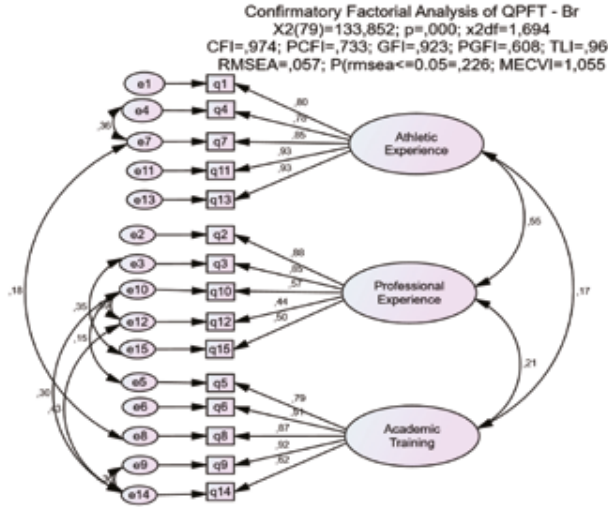
Figure 2. Factor load and intercorrelations between factors of each item in the three-factor model with 15 items of the Brazilian version of the Coaches’ Training Profile Questionnaire